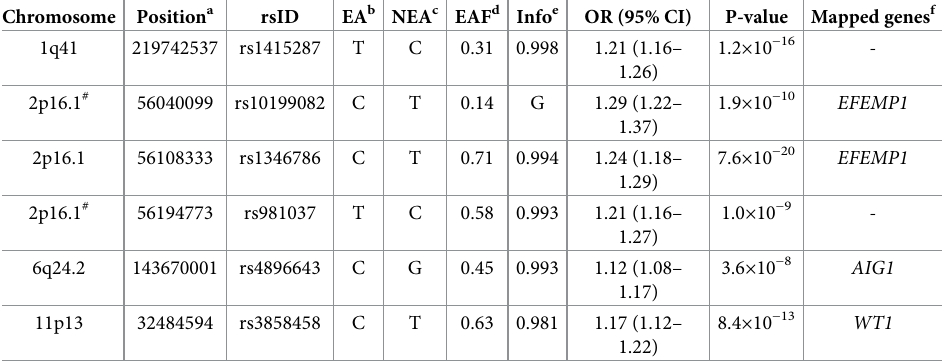
Table 2. Four loci significantly associated with overlap hernia in 5,219 cases and 26,095 controls in UK Biobank.